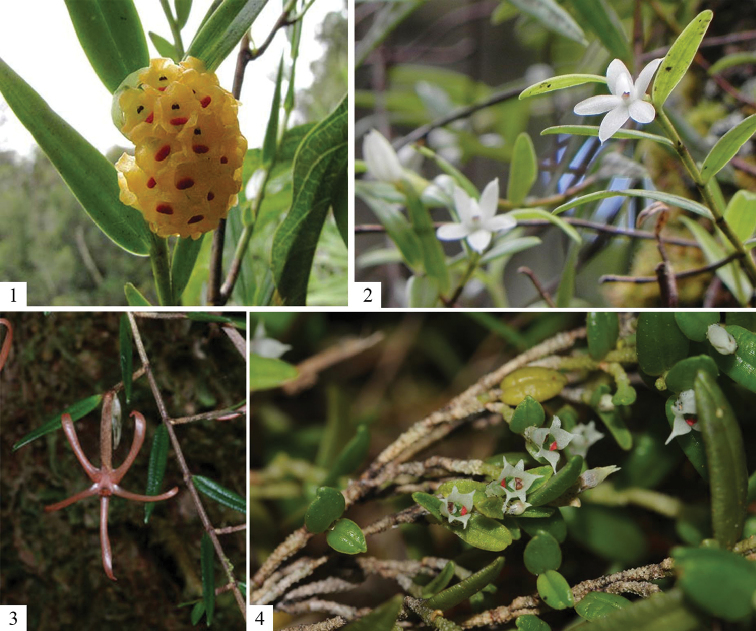
Photographs of Glomera species collected from online platforms. 1Glomeraaurea (photograph by Mehd Halaouate) 2Glomeramacdonaldii (photograph by Benoit Henry) 3Glomeratubisepala (photograph by Gary Yong Gee) 4Glomeraglomeroides (photograph by S.A. James).